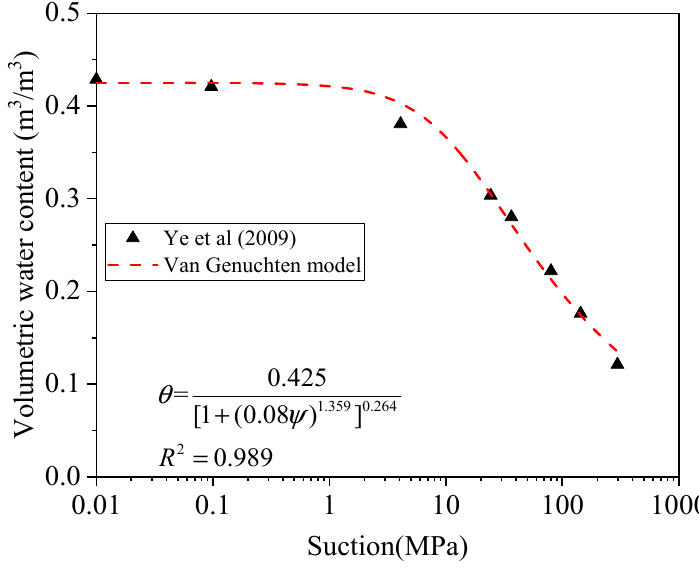
Figure 6. Soil water retention curve.